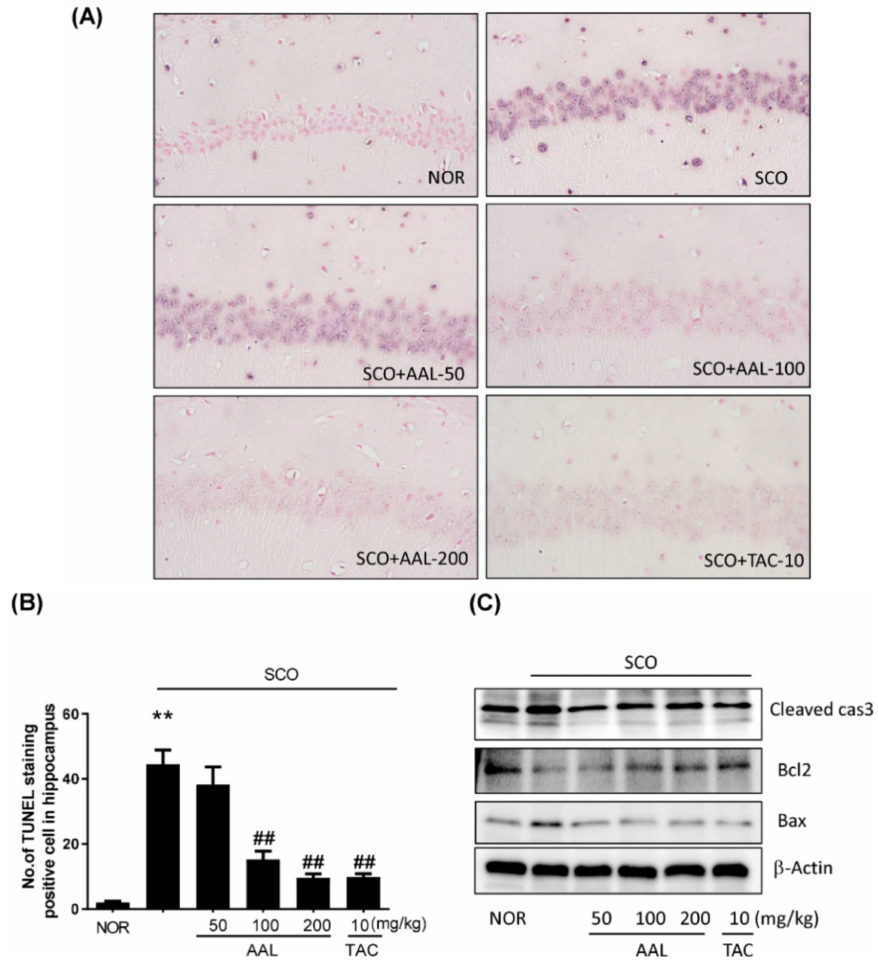
Figure 5. Effect of AAL extract on the expression of apoptosis-related proteins in scopolamine-induced cognitive deficit mouse brains. Representative photomicrographs were taken at magnifications of × 400 ( A ). Apoptotic